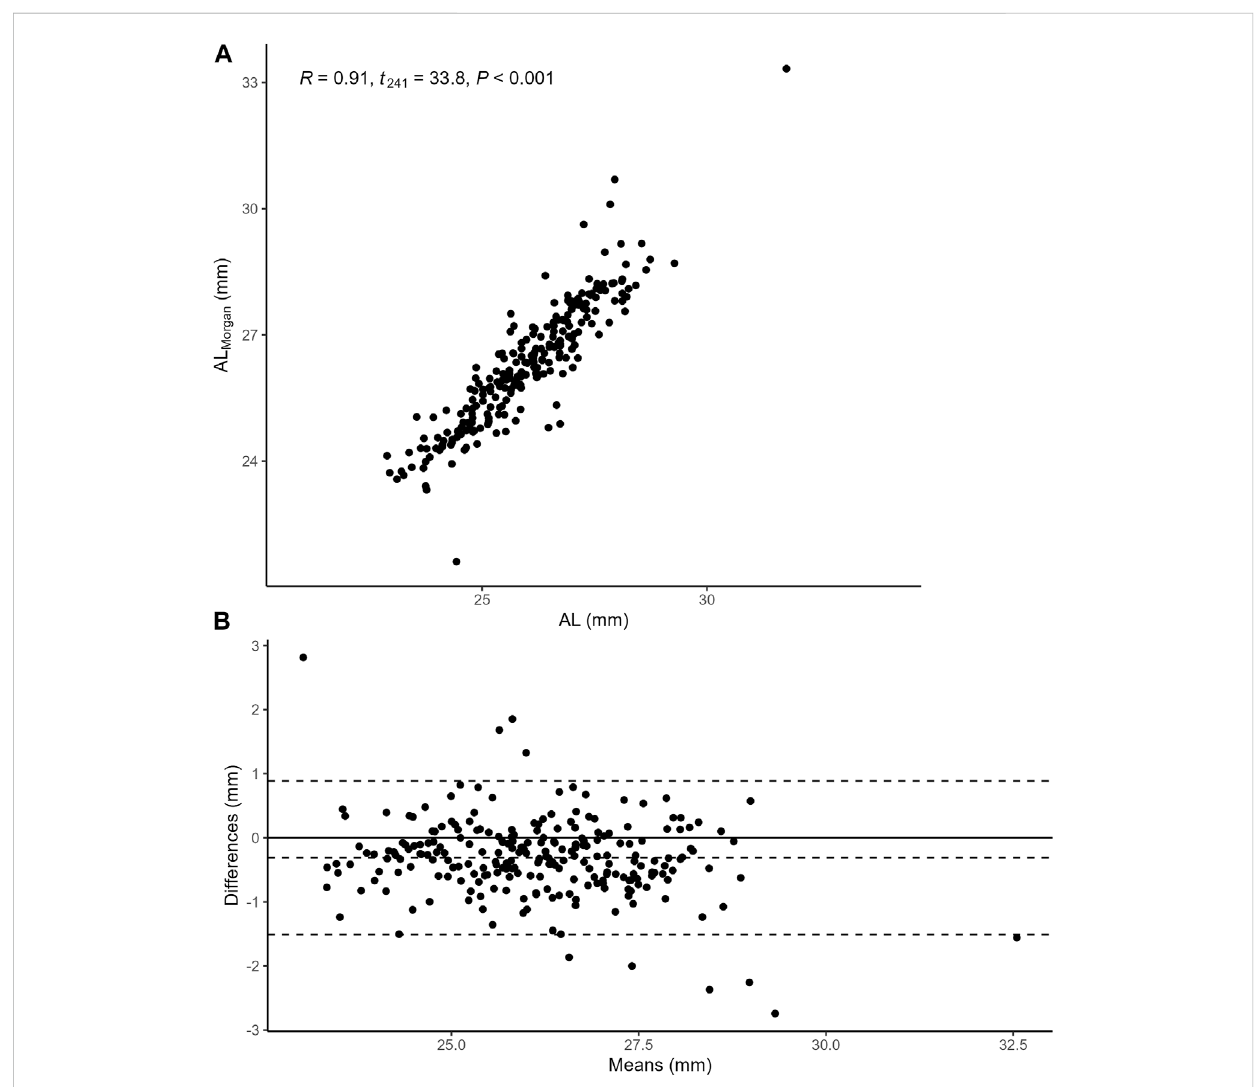
FIGURE 2 (A) the Pearson correlation between AL and AL Morgan . AL was closely associated with AL Morgan ( r = 0.91, t = 33.8, p < 0.001). Abbreviation: AL, Axial length. (B) Bland-Altman analysis of AL and AL Morgan . The AL Morgan values are 0.31 ± 0.61 mm larger than the AL values, with 95% limits of agreement from − 1.51 to 0.89